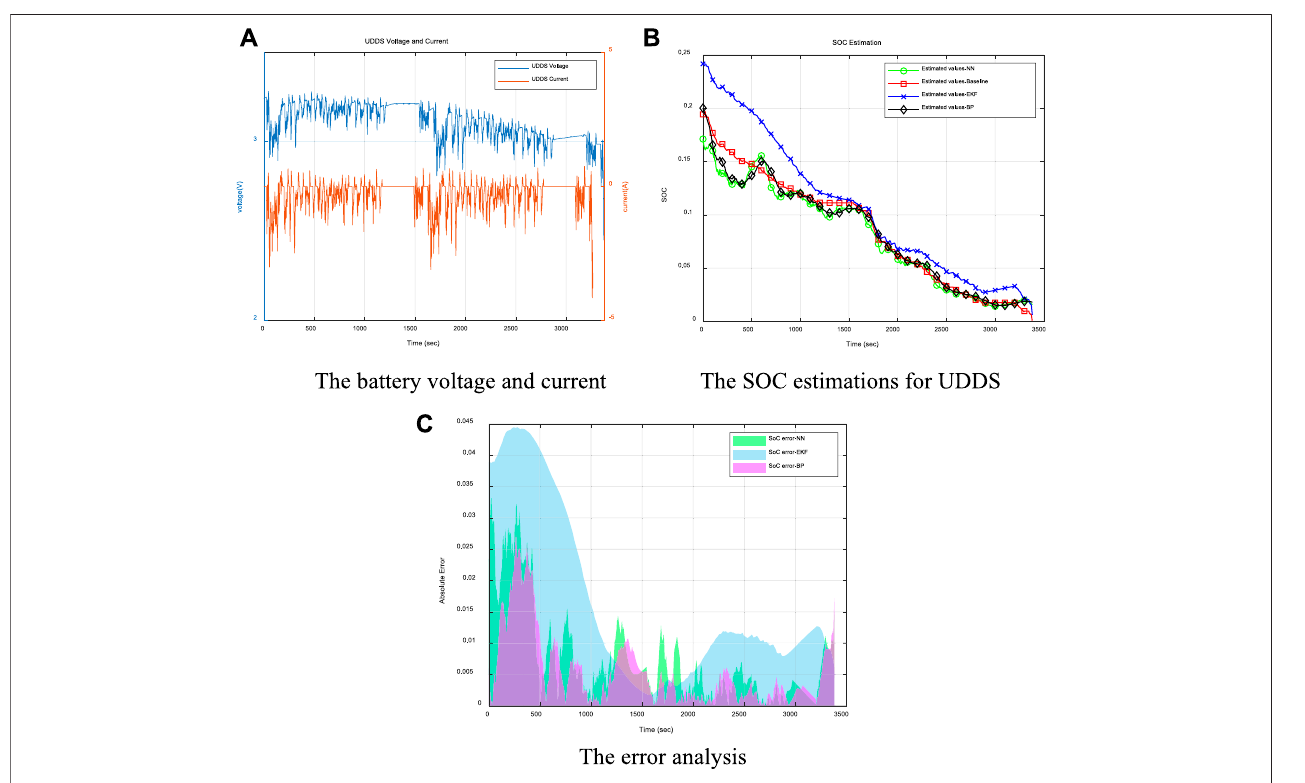
FIGURE11| TheevaluationresultsforlowbatterycapacityareaunderUDDSdrivingcycle. (A) Thebatteryvoltageandcurrent (B) TheSOCestimationsforUDDS. (C) The error analysis.